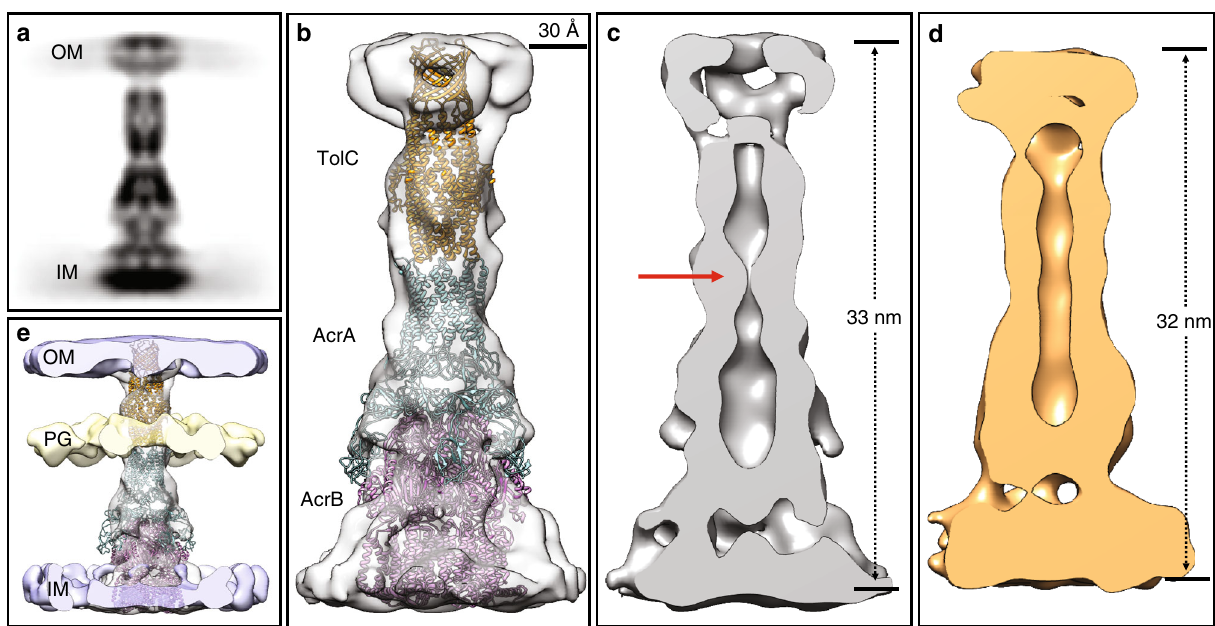
Fig. 2 In situ Cryo-ET structures of the fully assembled AcrAB – TolC complex. a The side-view projection of the subtomogram average of the pump in presence of antibiotics. b Isosurface rendering of a fi tted with high resolution cryo-EM model (PDB: 5V5S). c A slice through b showing a constriction at the boundary between AcrA and TolC (indicated by the red arrow). d A slice through the density map of the pump in presence of AcrB inhibitor (MBX3132). e Isosurface rendering of b overlaid with density map of the cell